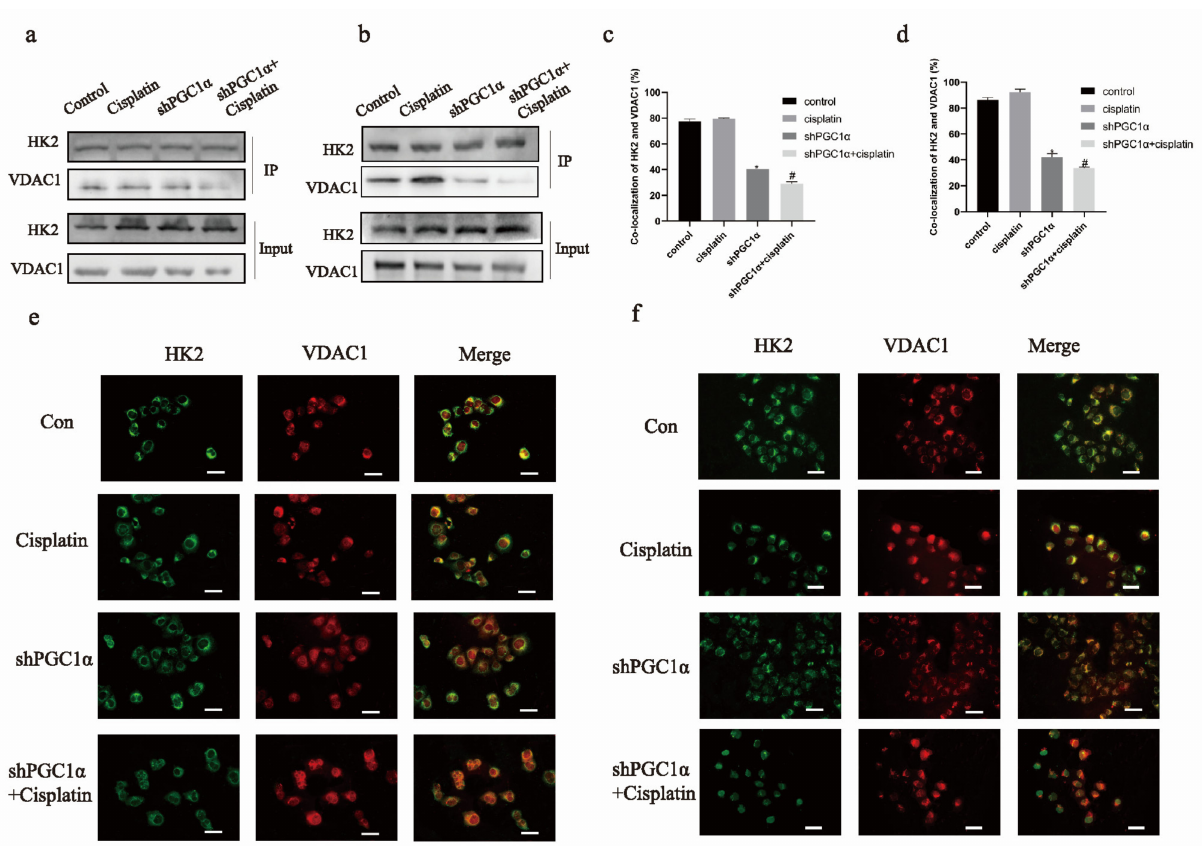
Figure 3. The knockdown of PGC1 α reduced the binding of HK2 and VDAC1 in ovarian cancer cisplatin-resistant cells. An immunoprecipitation assay was used to detect the binding of HK2 to VDAC1 in SKOV3/CDDP and A2780/CDDP cells and expressed as the mean ± SD; n = 3 ( a , b ). An immunofluorescence assay was used to detect the binding of HK2 to VDAC1 in SKOV3/CDDP and A2780/CDDP cells ( e,f ). The percentage of HK2 and VDAC1 localization was analyzed by ImageJ and expressed as the mean ± SD; n = 3, * p < 0.05 vs. control and # p < 0.05 vs. cisplatin ( c,d